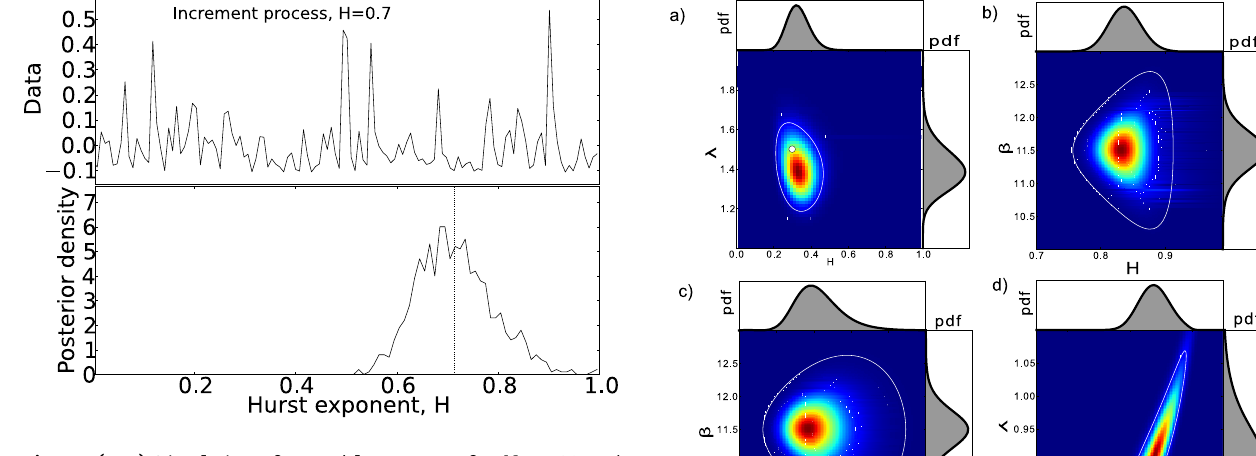
Fig. 5. (Top) Simulation of Rosenblatt process for N = 129 and H = 0 . 7. (Bottom) The averaged of the obtained posterior densities for point estimator derived with Bayesian method for 1000 such realizations.